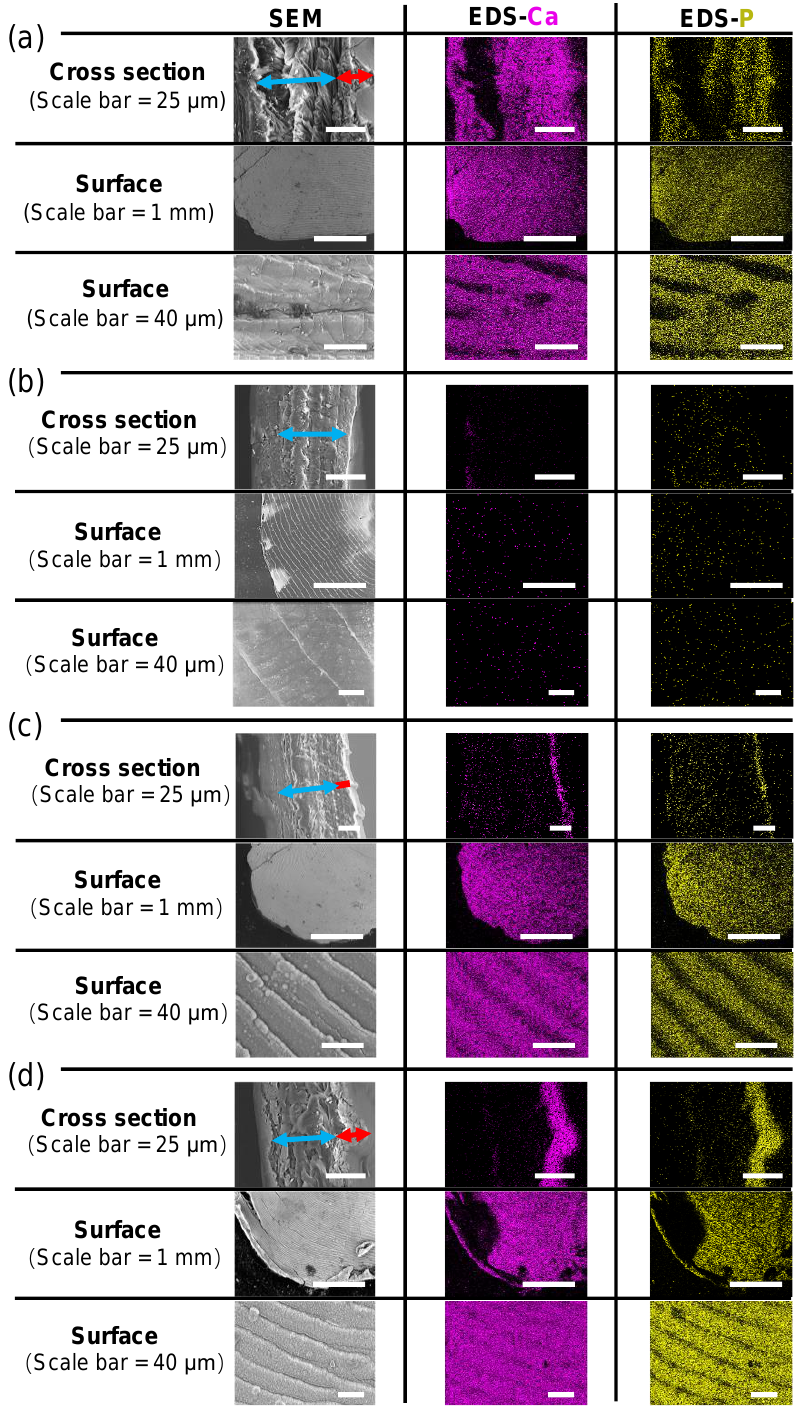
Figure 3. Representative SEM and EDS elemental mapping images of ( a ) S, ( b ) DS, ( c ) DS- 72 SSBF and ( d ) DS-K- 72 SSBF. The mapping was displayed with the Ca (purple-color) and P (yellow-color) dots. The blue and red arrows represent the internal and external layer regions, respectively.